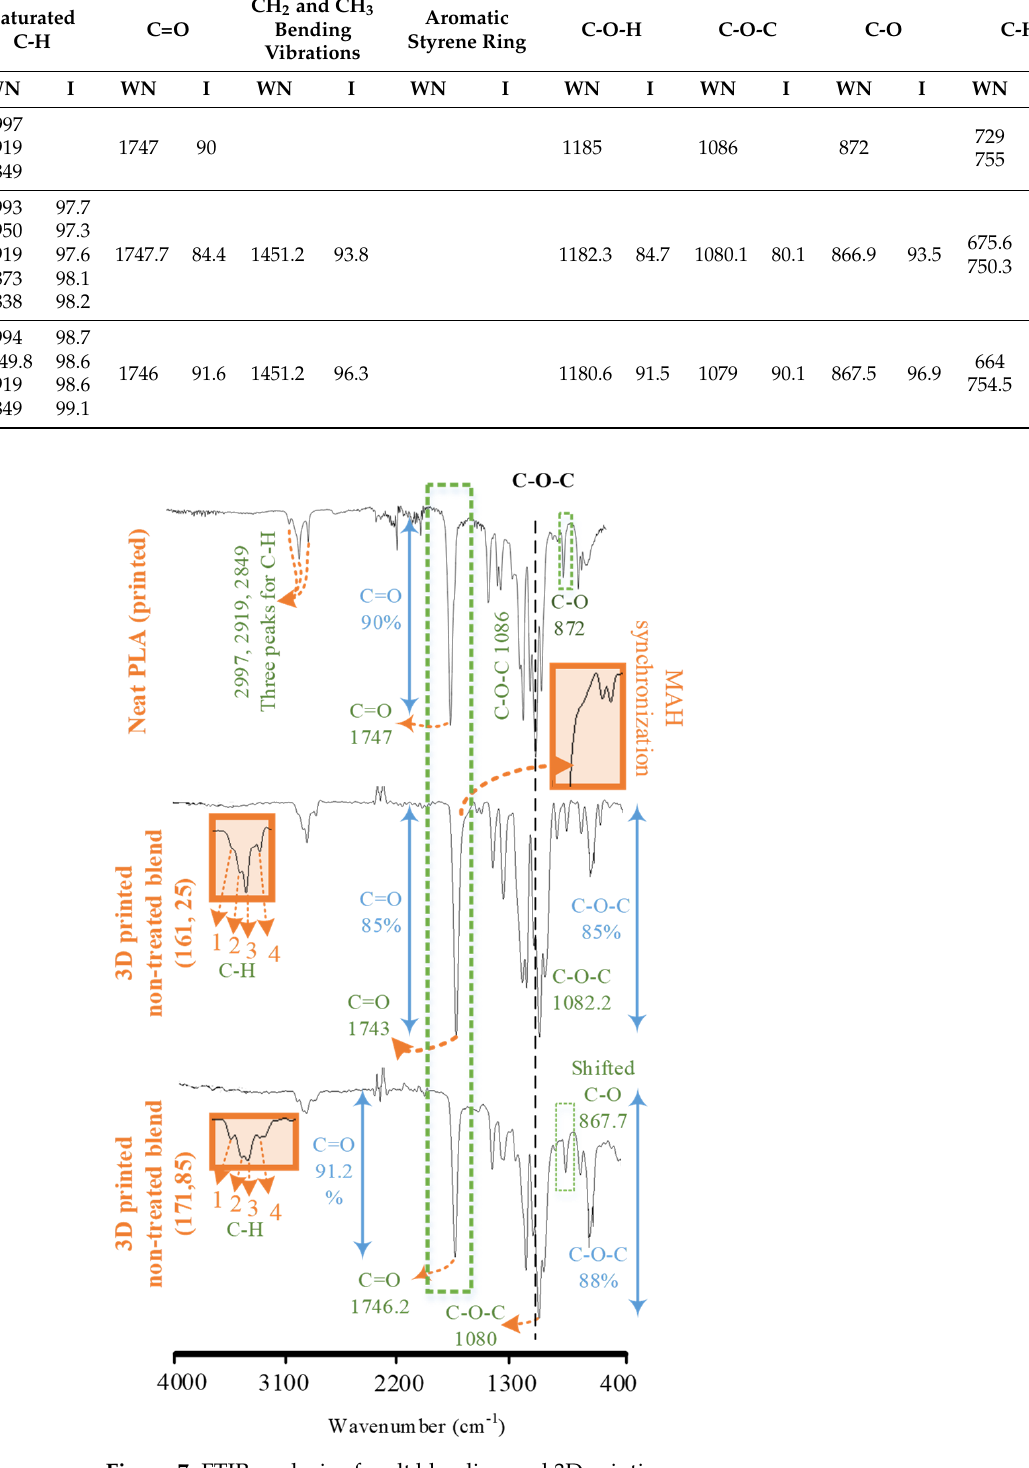
Table 6. FTIR analysis (“WN” stands for wave number, cm − 1 , and “I” stands for intensity).